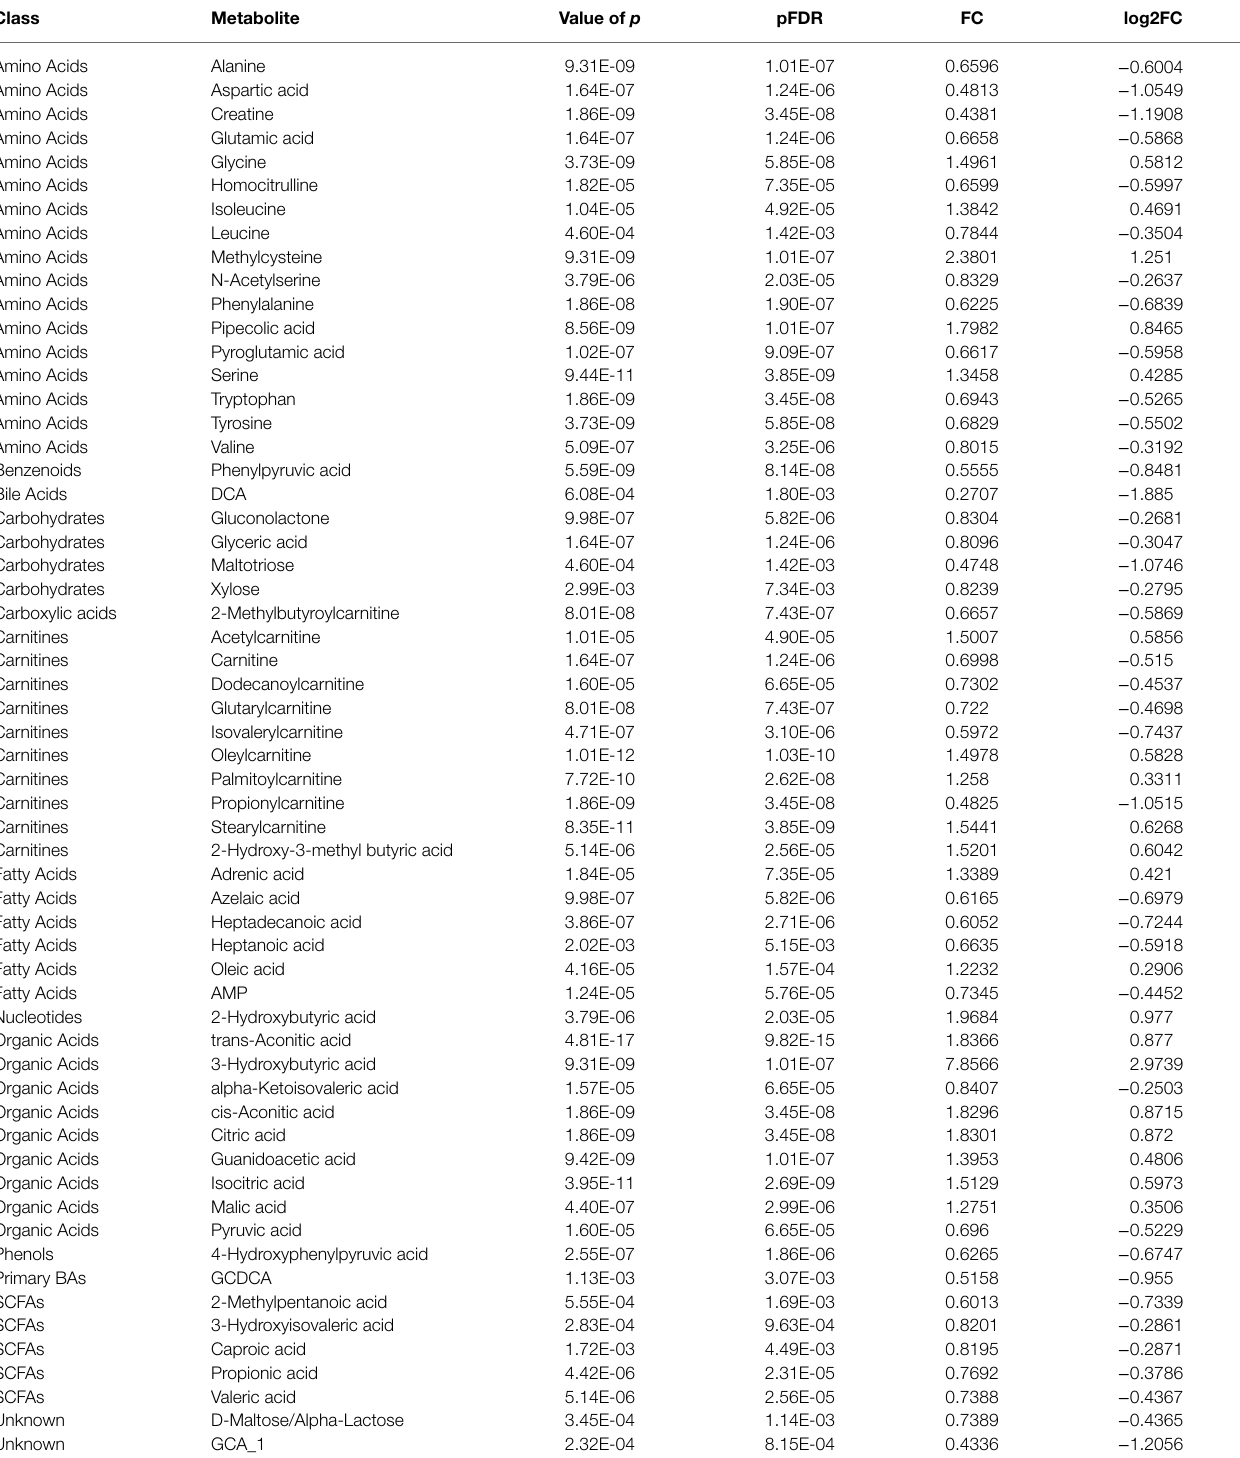
TABLE 3 | Changes in potential metabolites in children with metabolic syndrome following the